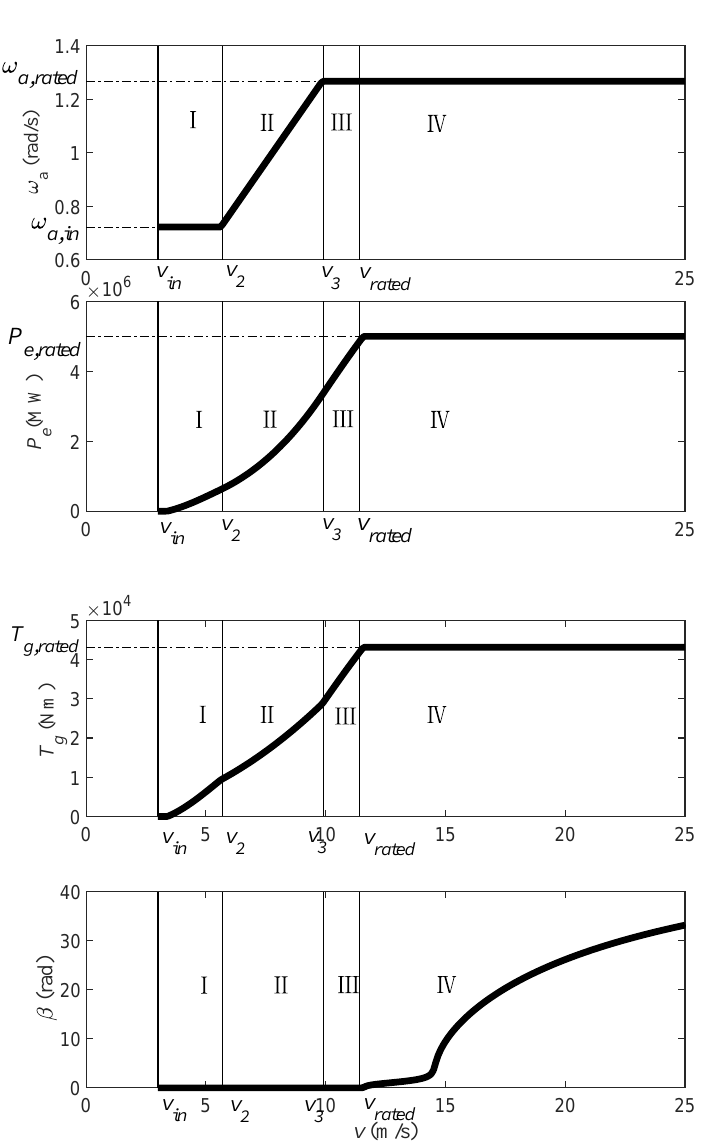
Figure 5. Optimal steady-state targets of the rotor speed ( ω a ), electric power ( P e ), generator torque ( T g ), pitch angle ( β ), under varying wind speed v